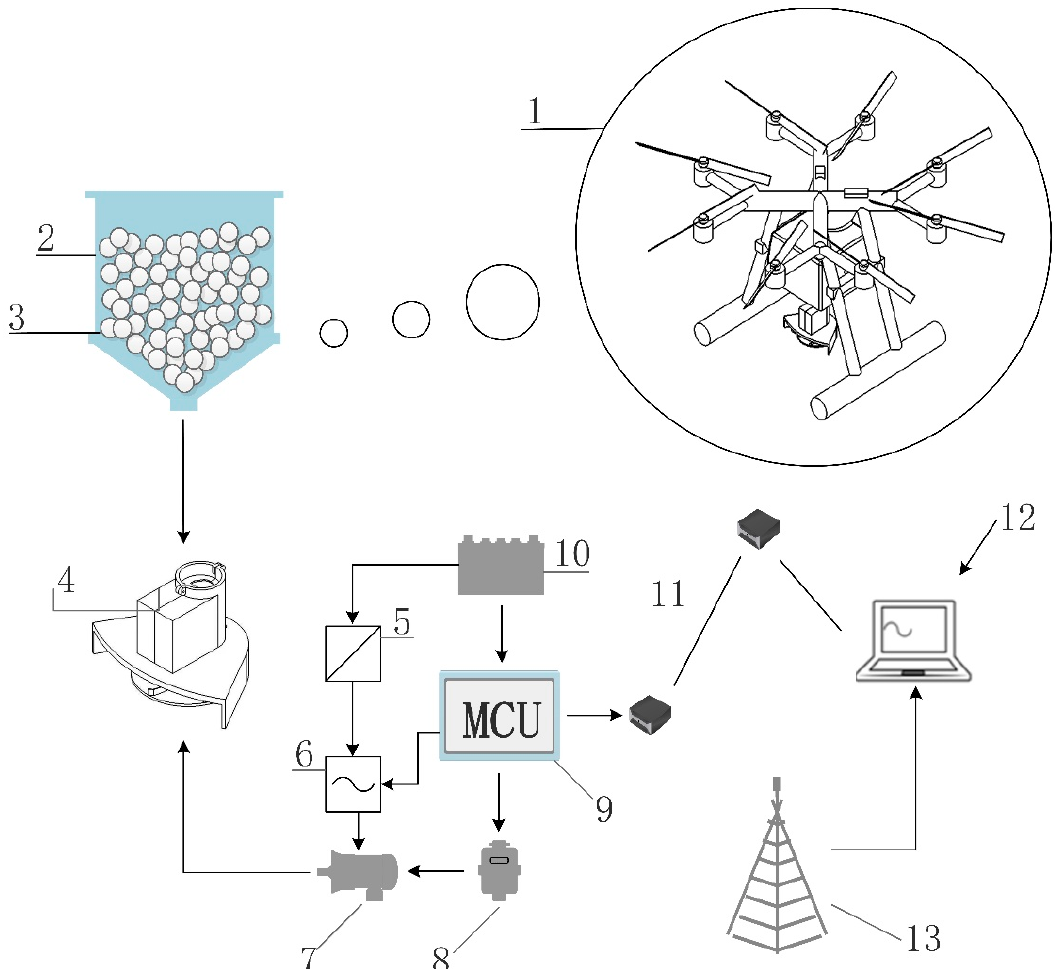
Figure 3. Control structure diagram of variable fertilizer application system. 1. Agricultural UAV 2. Fertilizer box. 3. Spreading granule. 4. Spreading device. 5. Voltage stabilization module. 6. PWM